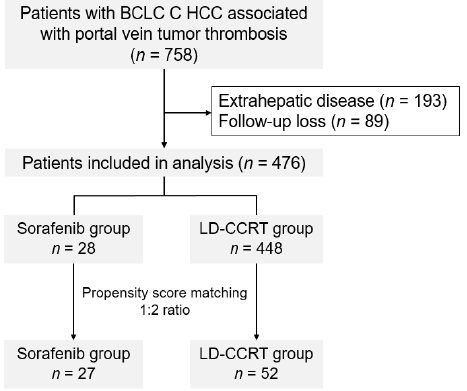
Figure 1. CONSORT (Consolidated Standards of Reporting Trials) diagram.